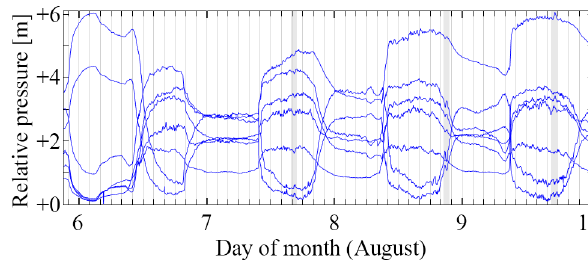
Figure 10. Relative pressure variations in 7 boreholes (orange sym- bols in Fig. 2) displaying common small amplitude diurnal oscil- lations with high-frequency content during August 2011. To make these visible in the same plot, we have applied offsets of 93, 71, 64, 61, 63, 66 and 27m to the measured pressures. Three common high-frequency features are highlighted by grey vertical